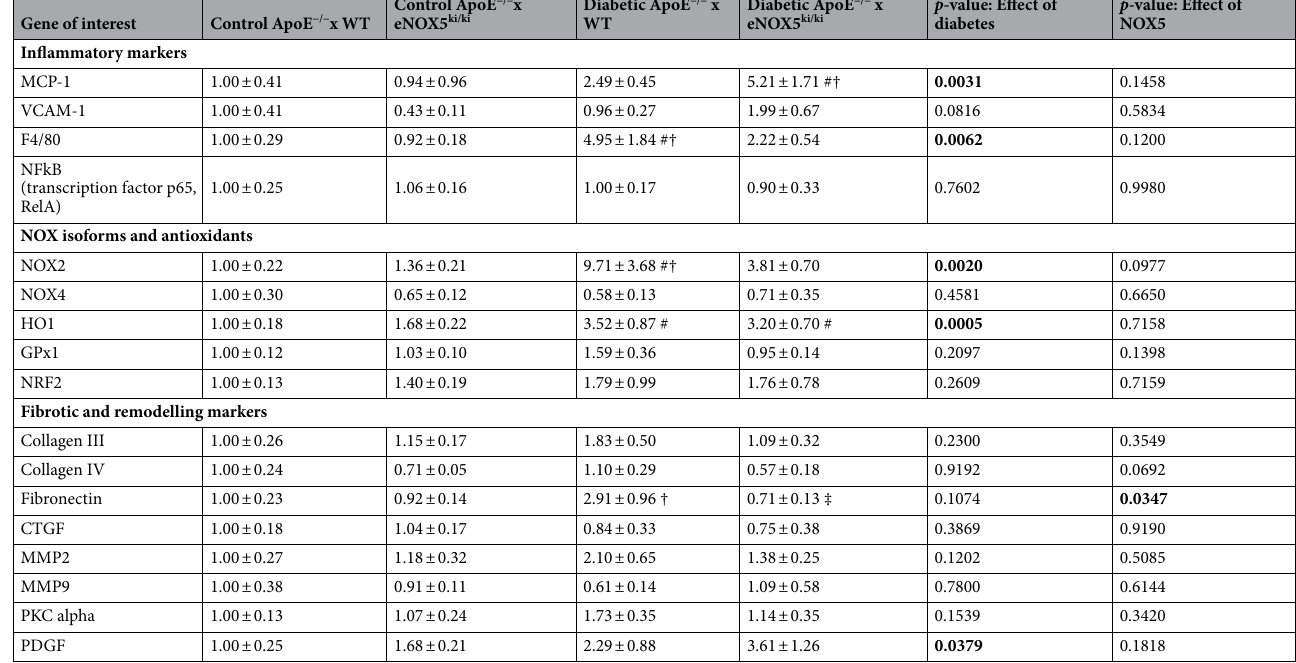
Table 4. RT-PCR gene expression data for ApoE −/− x NOX5 ki/ki animals and their respective WT